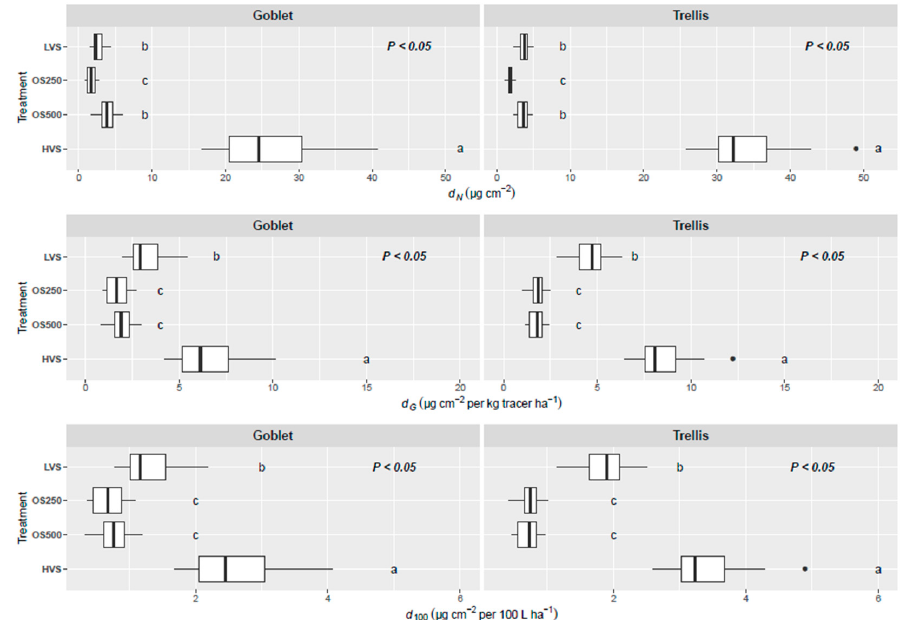
Figure 8. Deposition on the ground for the four sprayer treatments. Normalized deposition ( d N — μ g cm − 2 ) [ top ], normalized deposition ( d G ) per kg of tracer per ha ( µ g cm − 2 per kg of tracer per ha) [ middle ] and normalized deposition per 100 L of spray liquid per ha (d100— μ g cm − 2 per 100 L ha − 1 ) [ bottom ] for the four different sprayers for the goblet and trellis training systems. Boxplots show the median for each treatment, box boundaries show the 25th and 50th percentile, while whiskers extend to 1.5 times the interquartile range (IQR). Points beyond 1.5 times the IQR are plotted individually. See text for results of statistical analyses. Note the different scales for the three graphs. Table 5. The linear mixed effects model results for the effect of the sprayer on d N and d G or d 100 on ground losses for the trellis and goblet training systems. The analysis for d 100 is equivalent to that for d G as the two parameters differ only by a divisor of 2.5 (see Equations (3) and (4)). F -Value P -Value F -Value P -Value df Trellis Goblet d N (Fixed effect) Sprayer